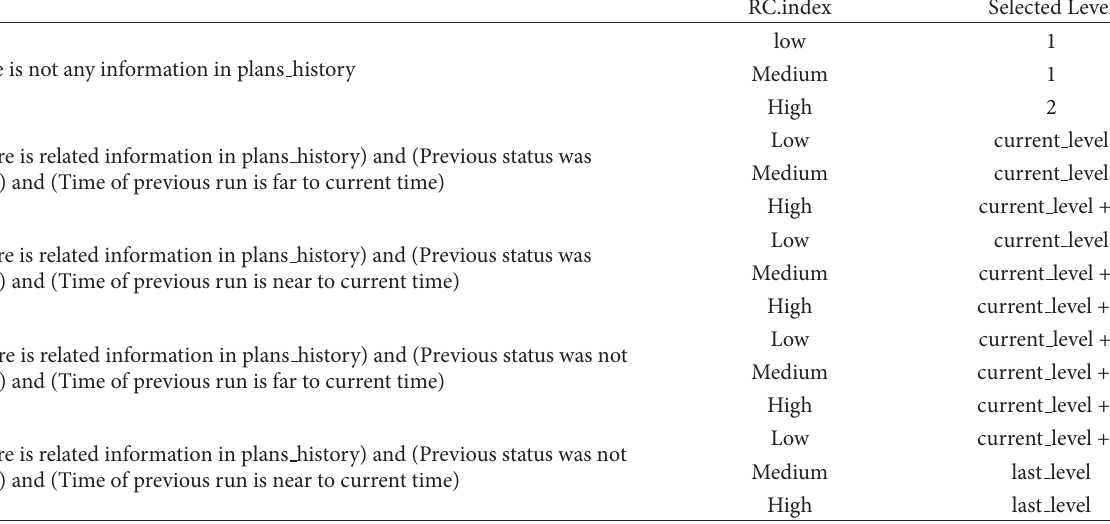
Table 2: Policies for dynamic response level